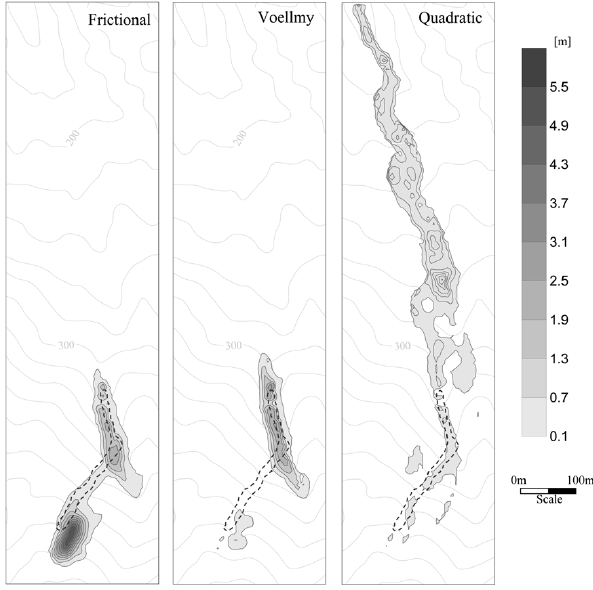
Fig. 7. Distressed hillside – filled depth contours of sliding debris. Comparison among Frictional, Voellmy and Quadratic rheologies using the best fit parameters obtained for the August 2005 debris flow. The dotted line indicates the extent of the August 2005 debris flow